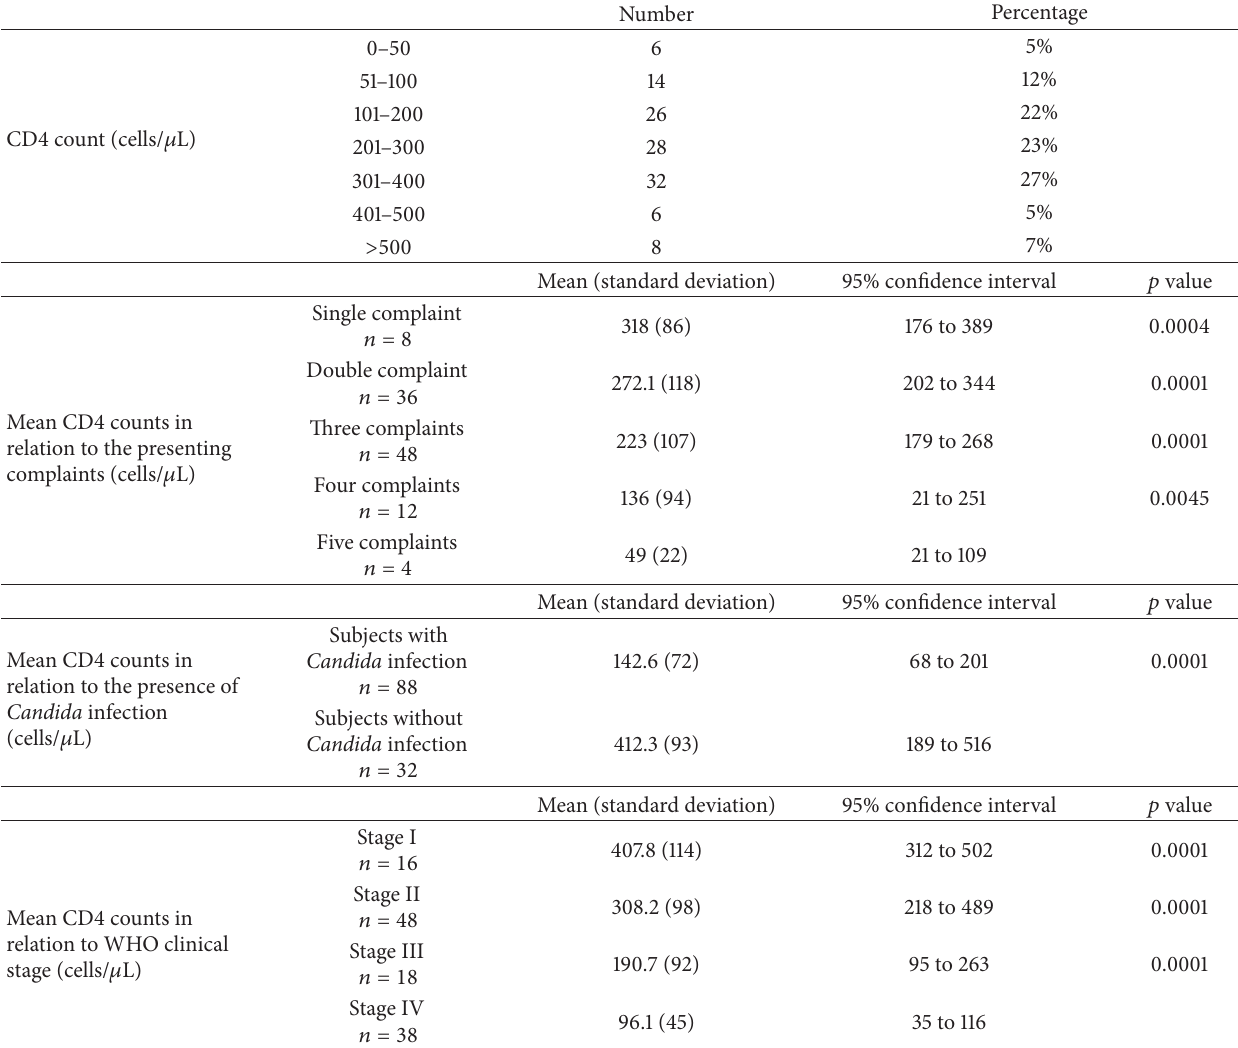
Table 3: Immunological profile of study subjects. 𝑛 = 120